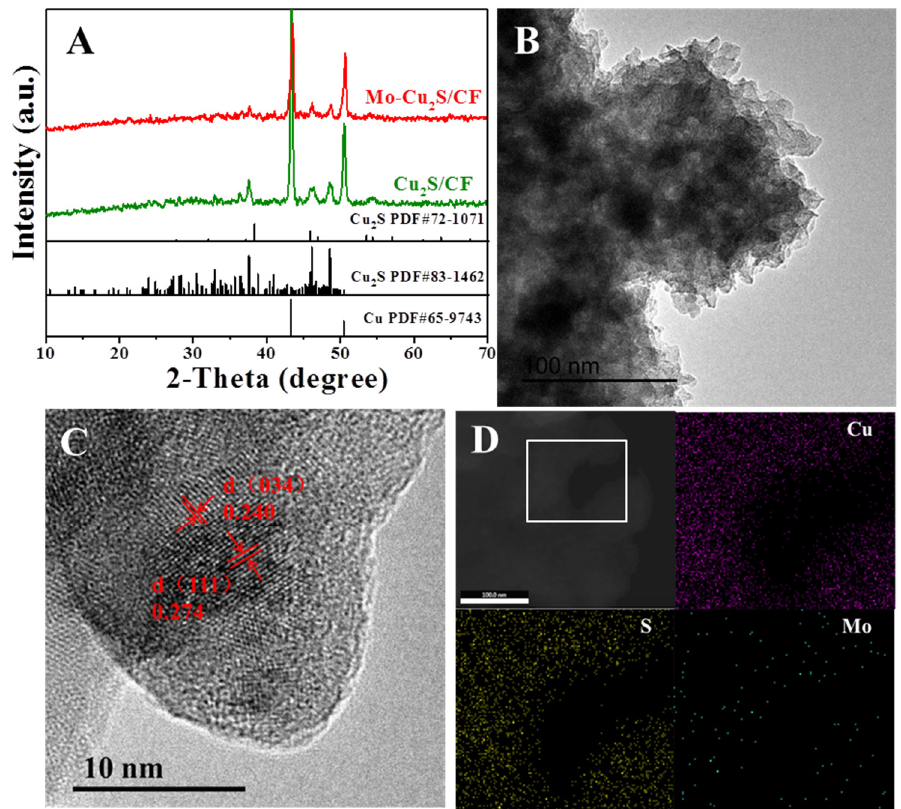
Figure 3. ( A ) XRD patterns of Mo-Cu 2 S/CF and Cu 2 S/CF; ( B ) TEM image; ( C ) the HRTEM image of Mo-Cu 2 S/CF; ( D ) the elemental mapping images.